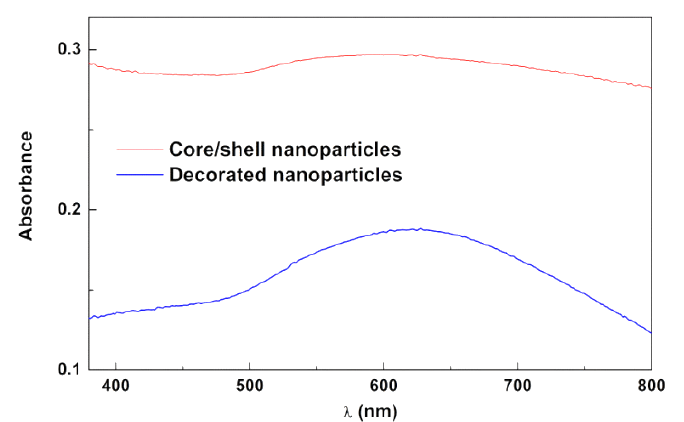
Figure 6. UV-Visible absorption spectra of aqueous dispersions of MnFe 2 O 4 nanoparticles decorated with gold and MnFe 2 O 4 /Au core/shell nanoparticles.